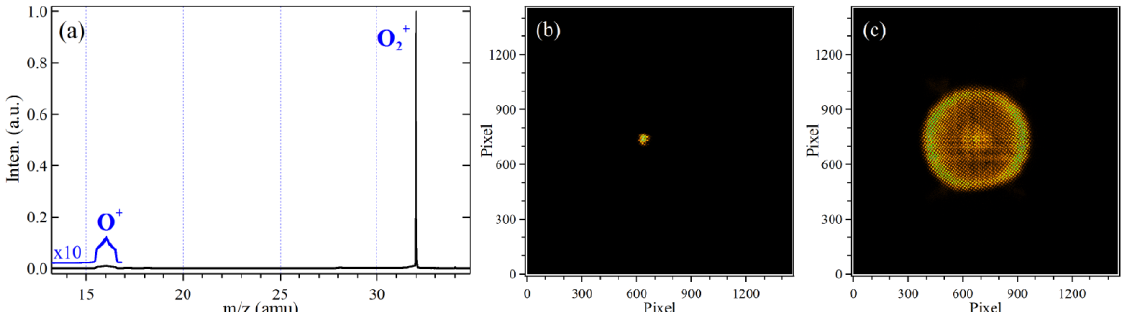
Figure 2. ( a ) Time-of-flight mass spectrum, ( b ) the O 2+ parent ion image, and ( c ) the O + fragment ion image.